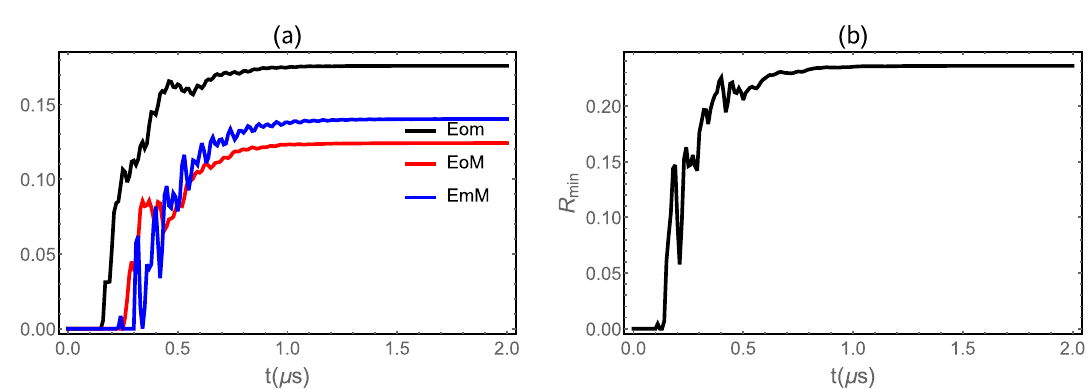
10 mK). ( b ) The residual contangle R min versus the 20.34 ( T = = 10 mK (black), T 80 mK (Red) and T = = 0 . See text for the other parameters. 4.8 MHz, � m 0.9 ω d , � c ω d and θ = = = = −